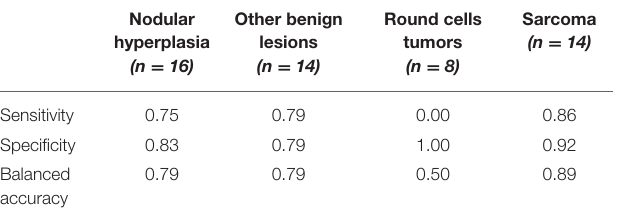
TABLE 5 | Results of the classification of the focal splenic lesions based on the machine learning-based decision tree. Nodular